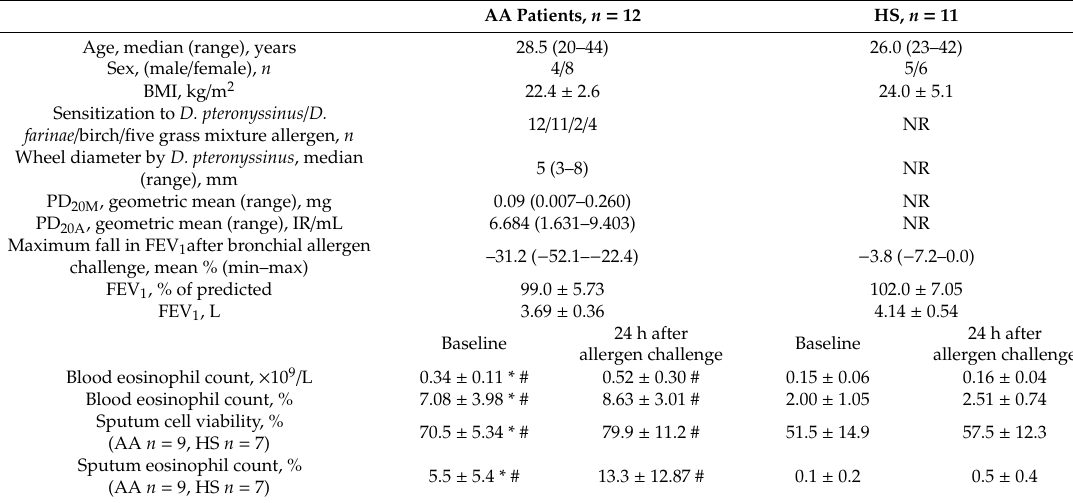
Table 1. Demographical and clinical data of study